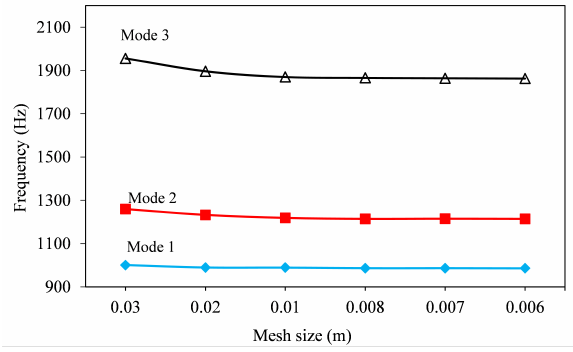
Figure 5: Mesh convergence of the intact model in the first three